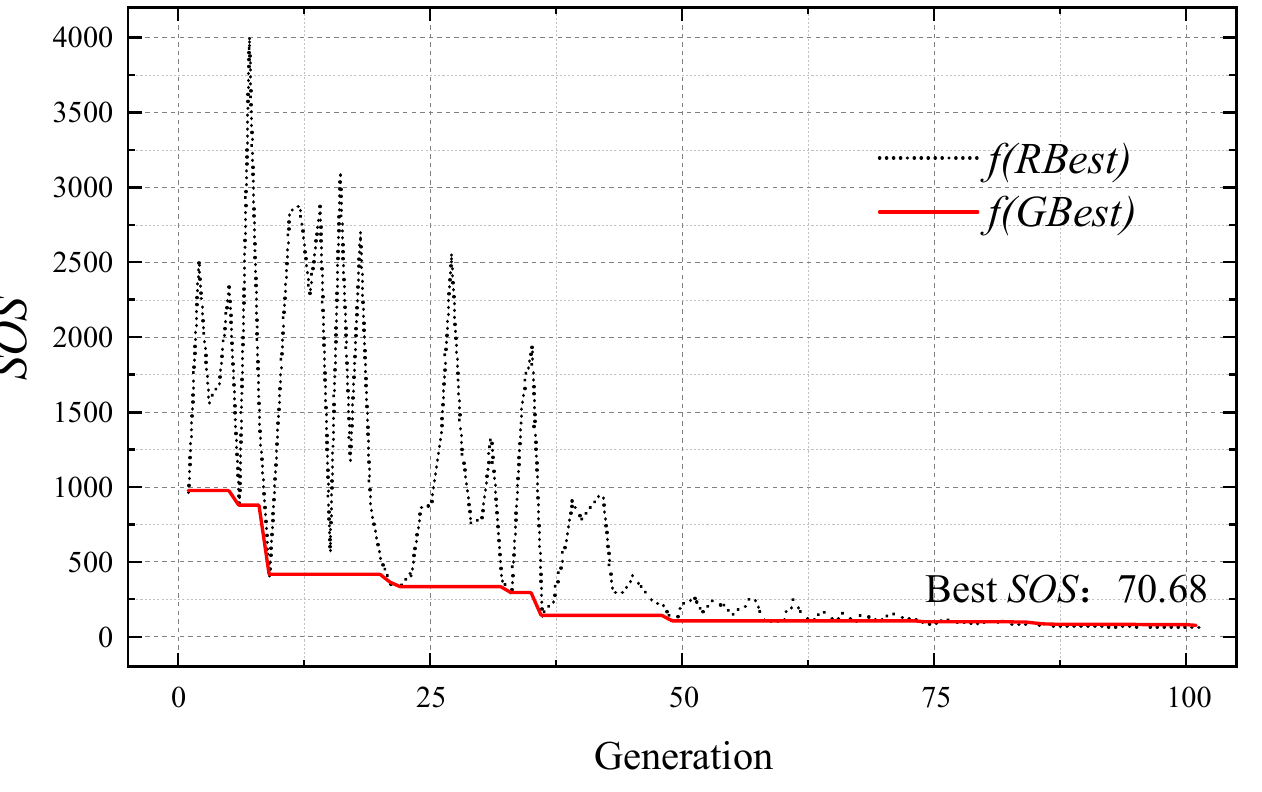
Figure 7. The convergence process of searching for the optimal SOS: Series 3 in Table 2.